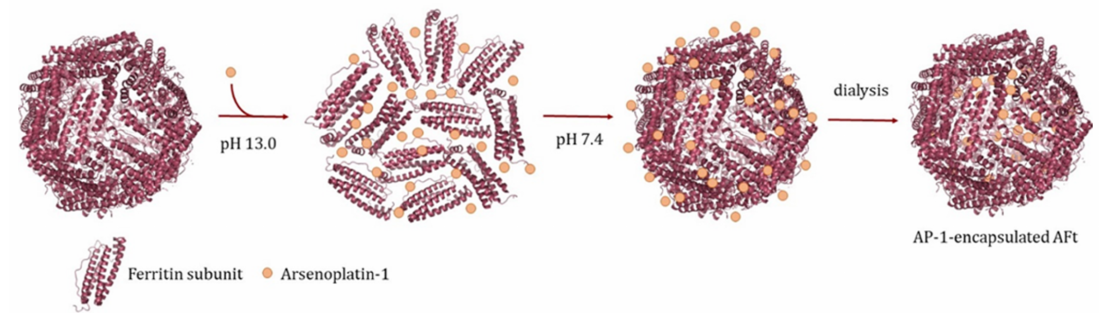
Figure 2. Schematic representation of the protocol used to encapsulate AP-1 within the AFt nanocage. To verify the formation of AP-1-encapsulated AFt and evaluate the amount of the drug that has been trapped within the protein cage, UV-vis spectroscopy and inductively coupled plasma-atomic emission spectroscopy (ICP-AES) were used. The UV-vis spectrum of AP-1-encapsulated AFt is reported in Figure 3A (violet line) superimposed to that of the control (black line). The absorption differences between 250 and 280 nm confirm that AP-1 was successfully encapsulated within the AFt nanocage. In turn, ICP-AES